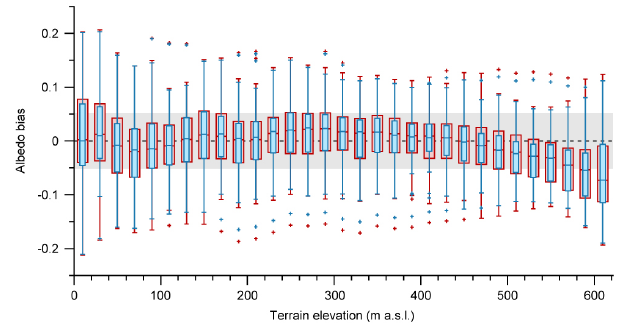
Fig. 5. Profile of biases between MODIS-derived albedo values and albedo values modelled using the IAM (blueish) and the FAM (red- dish). Data are based on the monthly values of the period March– October of the years 2001–2008. A positive bias signifies an over- estimation of albedo by the model and a negative bias an underes- timation. The grey shading represents the overall median RMSE of the FAM (0.054). Box plots are designed as in Fig.